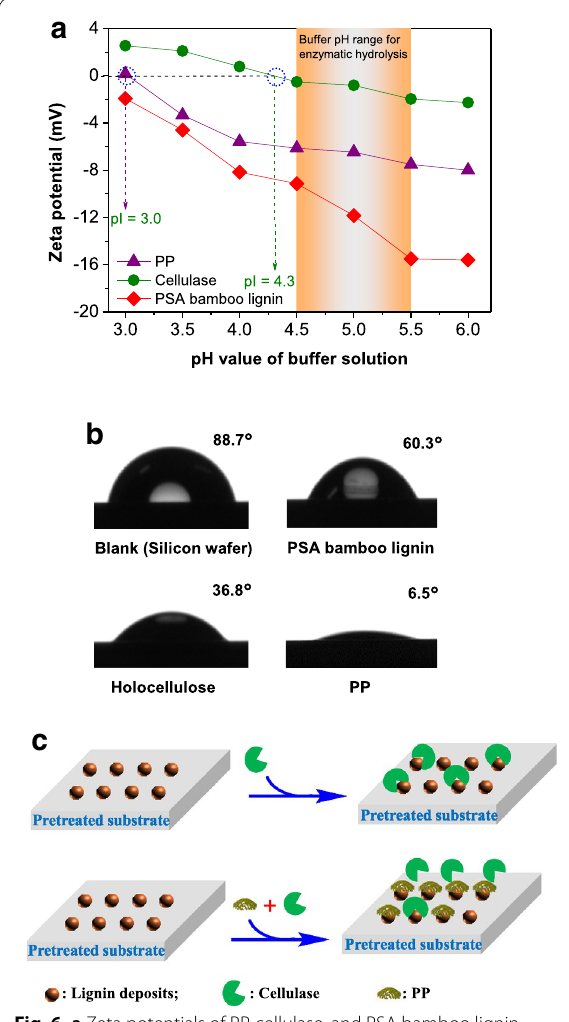
Fig. 6 a Zeta potentials of PP, cellulase, and PSA bamboo lignin solutions; b the contact angles of water on PSA bamboo lignin, holocellulose, and PP films coated on the silicon wafer; c a proposed mechanism for the promoting effect of PP on the enzymatic hydrolysis of glucan in pretreated substrates